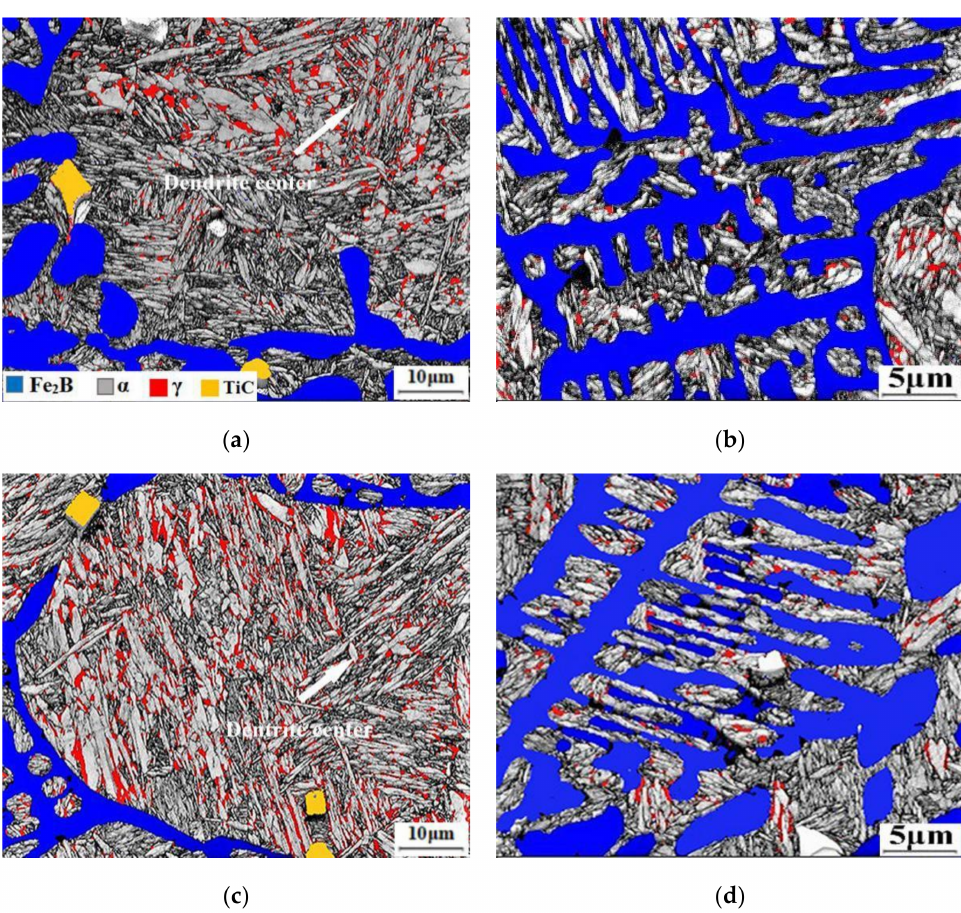
Figure 8. EBSD phase map analysis results of samples: ( a , b ) tq = 60 s, ( c , d ) tq = 120 s. Difference of RA morphology is detected in the as-cast sample and in the Q&P treated ones by TEM, as shown in Figure 9. The blocky RA is observed in the eutectic microstructure of as-cast samples from Figure 9a,b, with a width of about 0.7 µ m. However, after